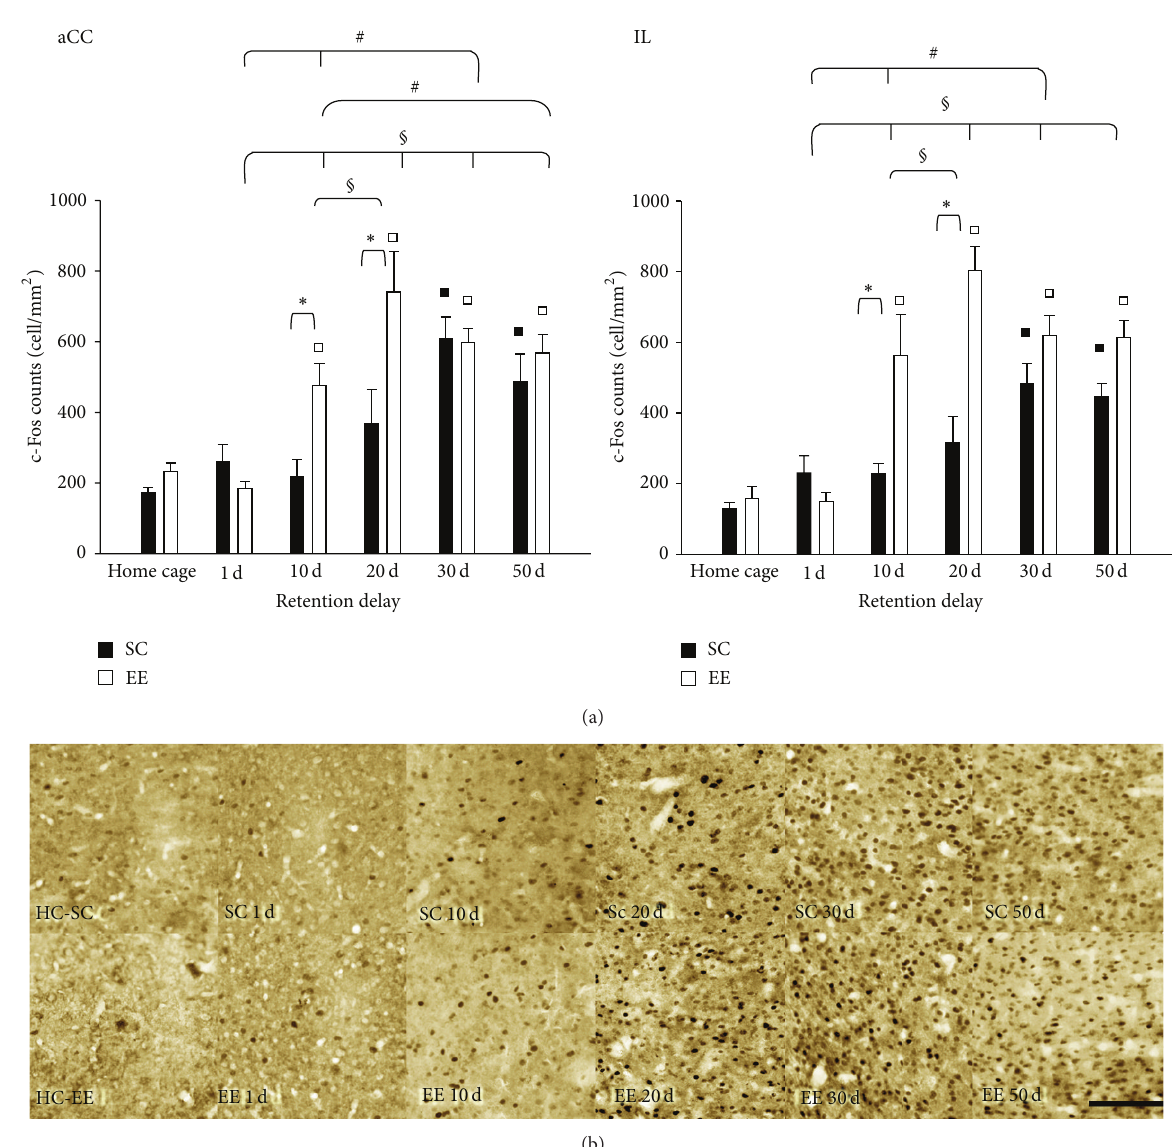
Figure 3: (a) c-Fos protein expression in aCC and IL. aCC : two-way ANOVA post hoc analysis Holm-Sidak method, HC-SC versus HC-EE 𝑃 = 0.384 ; statistical significance for EE versus HC-EE at 10, 20, 30, and 50 days, and for SC versus HC-SC at 30 and 50 days, all 𝑃 values < 0.05. Statistical difference between EE and SC at 1 day, 𝑃 = 0.376 ; at 10 and 20 days, 𝑃 < 0.01 ; at 30 days, 𝑃 = 0.899 ; at 50 days, 𝑃 = 0.383 . Statistical difference within EE group were found between 10 and 20 days, and 1 day versus 10, 20, 30, and 50 days, all 𝑃 < 0.05 . Statistical difference within SC group were found between 1 and 30 days, and 10 day versus 30 and 50 days, all 𝑃 < 0.05 . IL : two-way ANOVA post hoc analysis Holm-Sidak method, HC-SC versus HC-EE, 𝑃 = 0.451 ; statistical significance for EE versus HC-EE at 10, 20, 30, and 50 days, and for SC versus HC-SC at 30 and 50 days, all 𝑃 values < 0.05. Statistical differences between EE and SC at 1 day, 𝑃 = 0.300 ; at 10 and 20 days, 𝑃 < 0.01 ; at 30 days, 𝑃 = 0.084 ; at 50 days, 𝑃 = 0.055 . Statistical differences within EE group were found between 10 and 20 days, and 1 day versus 10, 20, 30, and 50 days, all 𝑃 < 0.05 . Statistical difference within SC group were found between 1 and 30 days, and 10 day and 30 days, all 𝑃 < 0.05 . ◼ Statistical significance between EE and HC-EE; ◻ statistical significance between SC and HC-SC; ∗ statistical significance between EE and SC; § = statistical significance for factor day within EE group; # = statistical significance for factor day within SC group; error bars = s.e.m. (b) Representative panel of c-Fos protein expression in aCC for EE and SC animals, for all recall probe tests; scale bar 100 𝜇